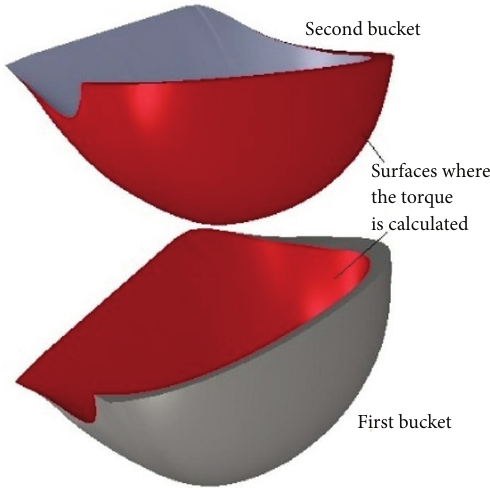
Figure 5: Two consecutive half buckets used to calculate the total runner